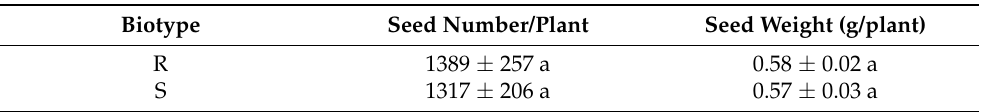
Figure 1. ( A ) Leaf number, ( B ) plant height, ( C ) dry weight of ALS-resistant and ALS-susceptible redroot amaranth biotypes grown under noncompetitive conditions. Bars indicate standard error. Table 2. Seed production for ALS-resistant and ALS-susceptible biotypes under noncompetitive conditions ( ± SE).